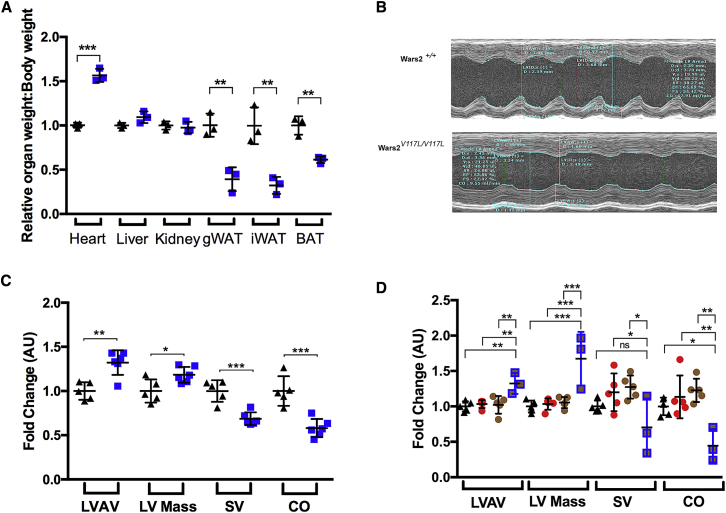
The Wars2V117L Allele Causes Hypertrophic Cardiomyopathy(A) Organ weight divided by body weight at 6 months of age in male mice. Wars2V117L/V117L and Wars2+/+ animal numbers were 3 and 3, respectively; mean ± SD. Data were analyzed with multiple t tests by the Holm-Sidak method.(B) Representative echocardiogram images of the left ventricle in male Wars2V117L/V117L and Wars2+/+ mice at 6 months of age.(C) Functional analysis of images for left ventricle anterior wall (LVAW) diameter, left ventricle (LV) mass, stroke volume (SV), and cardiac output (CO). Wars2V117L/V117L and Wars2+/+ male mice animal numbers were 6 and 5, respectively; mean ± SD. Data were analyzed using an ordinary one-way ANOVA with Tukey’s post hoc test to correct for multiple comparisons.(D) Echocardiogram analysis in Wars2V117L/− male mice at 6 months of age. Wars2V117L/−, Wars2V117L/+, Wars2+/− and Wars2+/+ animal numbers were 3, 5, 5, and 5, respectively; mean ± SD. Data were analyzed using an ordinary one-way ANOVA with Tukey’s post hoc test to correct for multiple comparisons.∗p < 0.05, ∗∗p < 0.01, ∗∗∗p < 0.001. Wars2V117L/V117L mice are blue squares, Wars2+/+ mice are black triangles, Wars2V117L/+ mice are red filled circles, compound heterozygote Wars2V117L/− mice are brown filled blue squares, and Wars2+/− mice are brown circles.